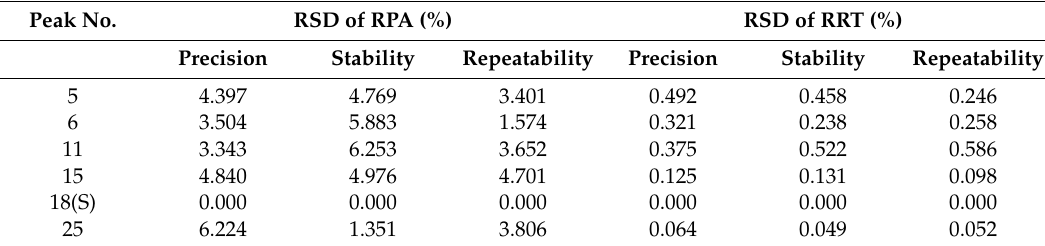
Table A2. Analytical results of precision, stability, and repeatability rates of fourteen components in the T. patula .